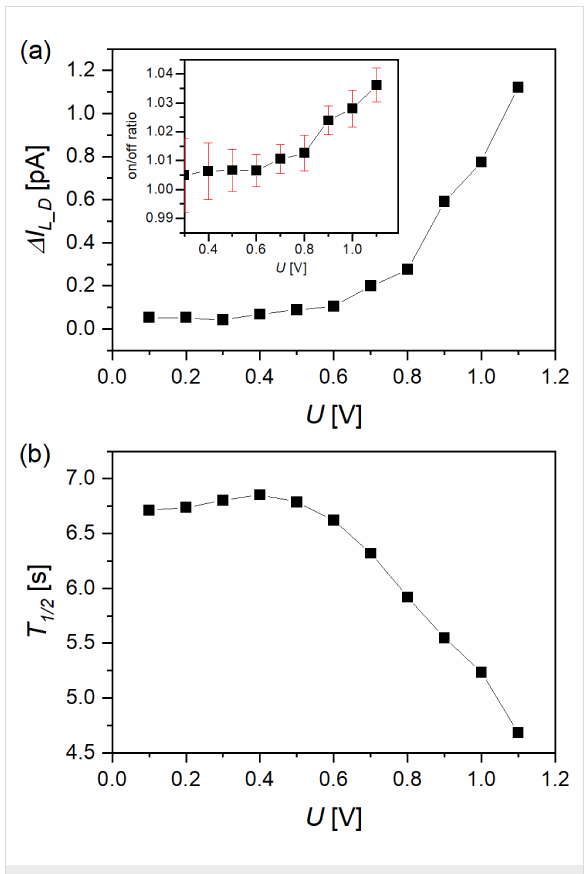
Figure 6: Photoconductance of Ru(MPTP) 2 –AuNP devices. (a) Differ- ence between light current and dark current, Δ I L_D ; inset: on/off ratio. Red bars indicate one standard deviation. (b) Half-life of current decline after the peak induced by switching the light source “on” or